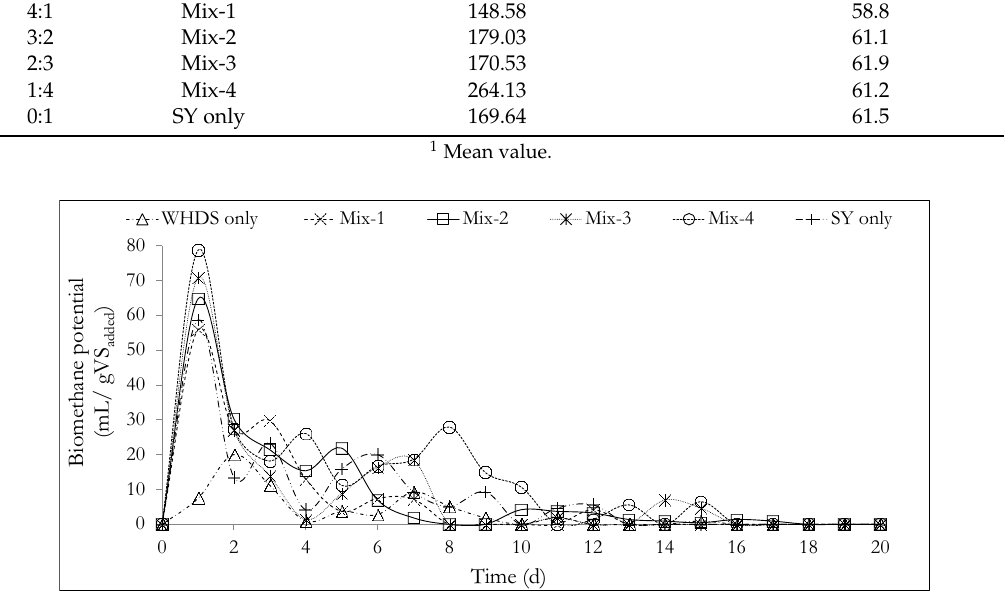
Figure 3. Daily biomethane potential from the different co-substrate mixtures investigated. The mass ratios of the volatile solids of WHDS to the volatile solids of SY for the different substrate mixtures are listed in Table 3. Table 3. Biomethane potential and biomethane contents of biogas generated from the degradation of the different substrate mixtures.